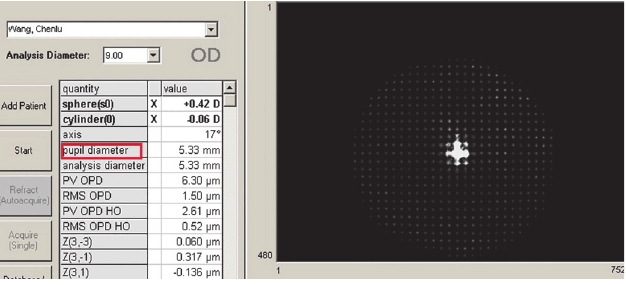
Fig 1. Measured area of wavefront aberration marked with a red rectangular frame.